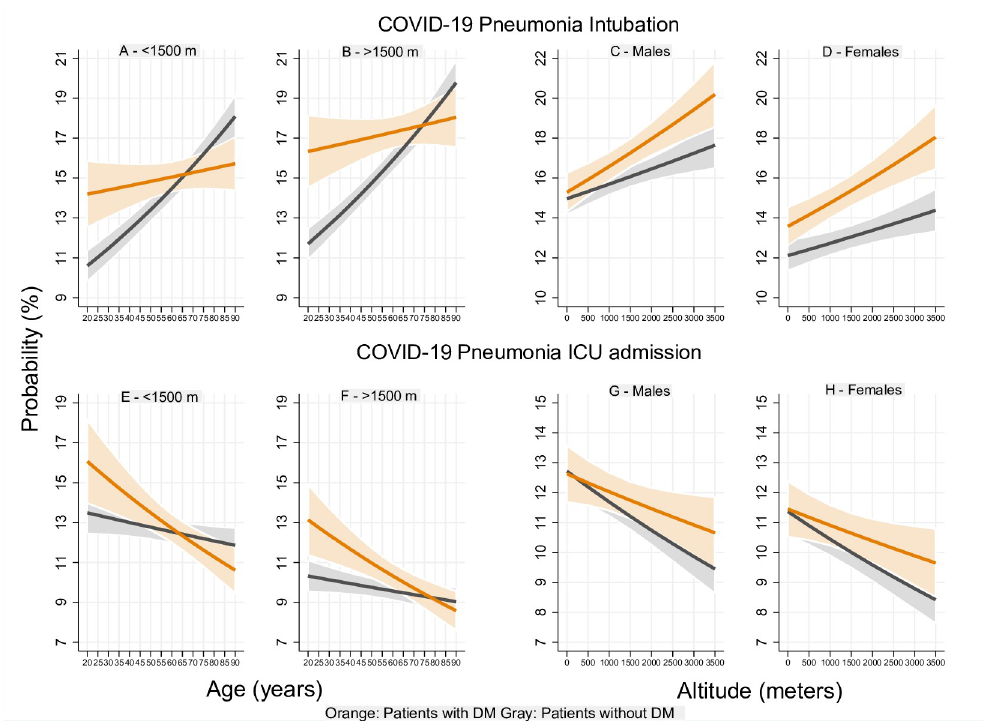
Fig 4. Event probability by age and altitude of residence in patients with COVID-19 pneumonia. Panel A-B show that the probability of intubation was higher for patients with DM up to 50 [at < 1500 m] [p < 0.05] and 65 years [at > 1500 m] [p < 0.05]. Panel C-D show that this probability was higher for males compared to that of women [p < 0.05]. There were no differences between male patients with and without DM at all altitudes [p � 0.05]. Panel E-F show that there were no significant differences in ICU admission between patients with and without DM [p � 0.05]. Panel G-H show that this probability decreased with altitude and that there were no significant differences between men and women with or without DM [p �